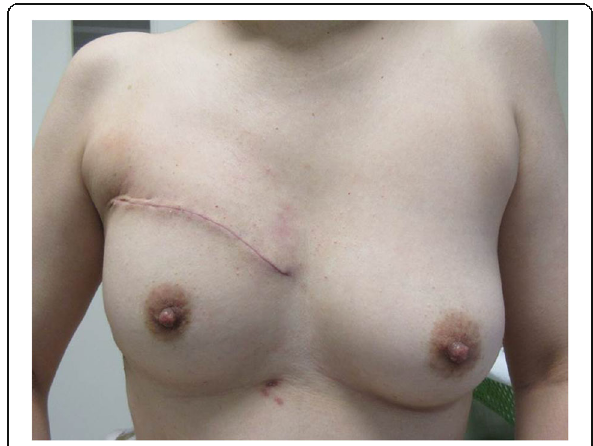
Fig. 4 The deficit of muscles was covered with the spared skin and breast, and severe deformation was